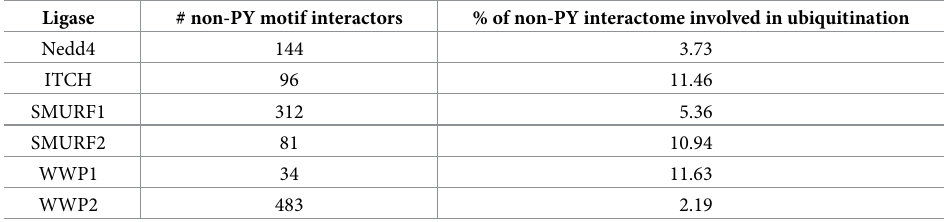
Table 2. Functional analysis of non-PY containing interactors involved in